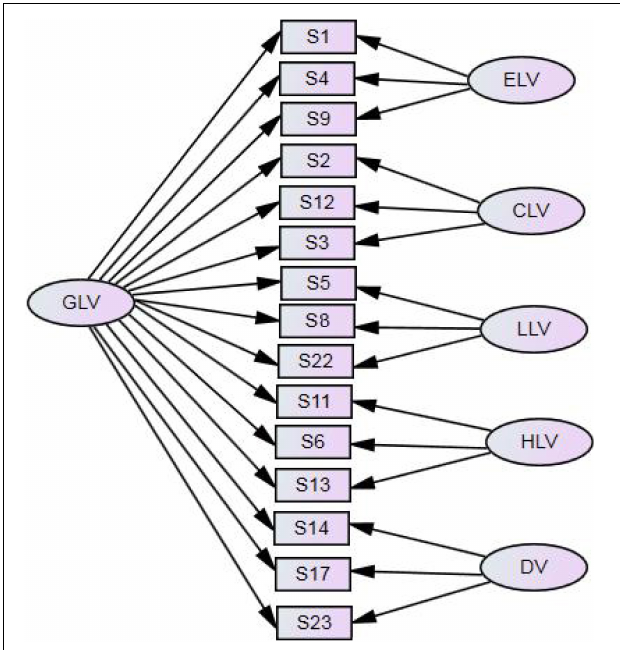
FIGURE 1 | The bifactor model diagram. GLV, general labor value; ELV, equal labor value; CLV, cherishing labor value; LLV, love labor value; HLV, honest labor value.